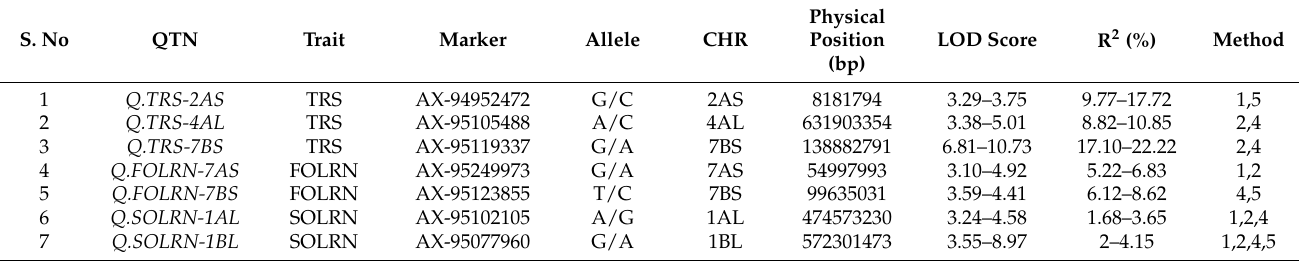
Figure 2. Population stratification of wheat association mapping panel. ( A ) Delta K, rate of change from 2 to 4. ( B ) Biplot of principal component analysis (PCA), PCA 1 and PCA 2. ( C ) Bar plot of the AM panel showing the structuring of two subpopulations (SP1 and SP2) in different colors, viz. SP1 (red, 40 genotypes), SP2 (green, 96 genotypes). Table 3. Common quantitative trait nucleotides (QTNs) of root and shoot traits identified using different multi-locus genome-wide association studies (GWAS)